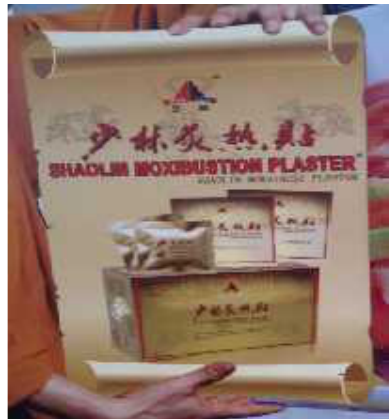
Figure 14.Shaolin Moxibusion